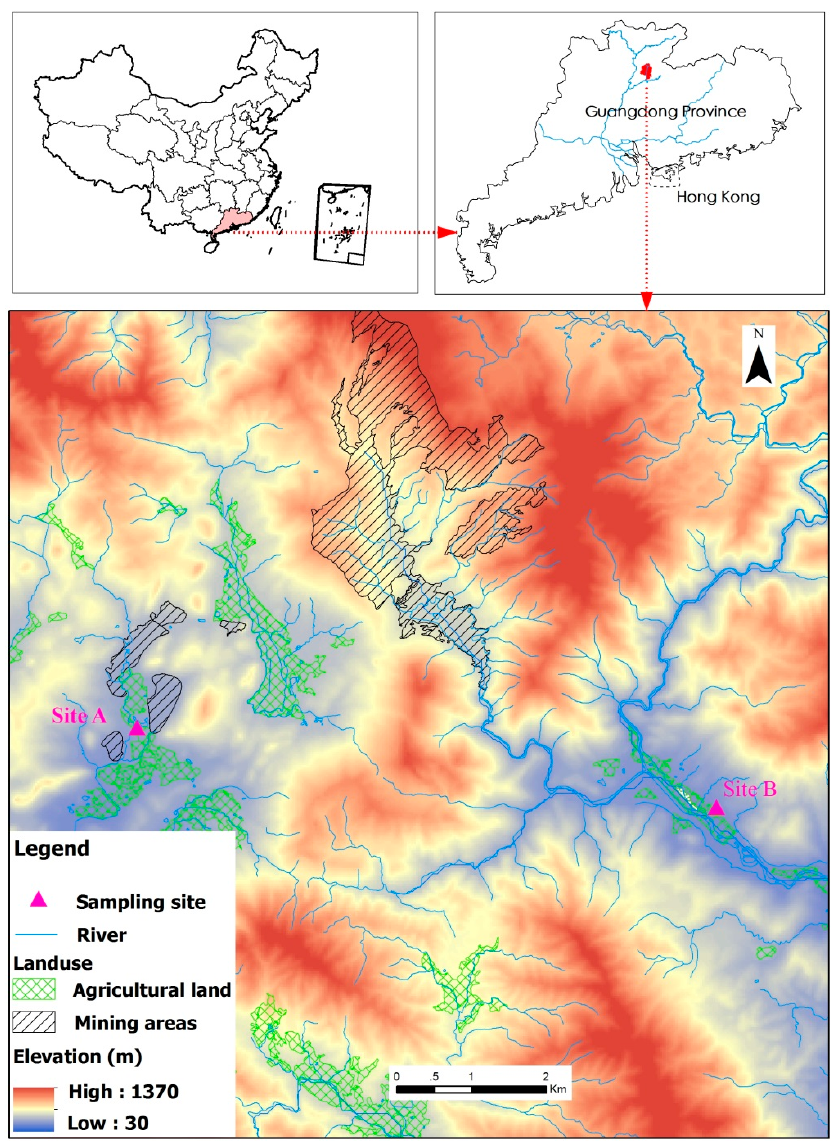
Figure 1. Locations of soil-sampling sites in Guangdong Province, southern China (the limestone-rich and red soils were collected from sites A and B, respectively).